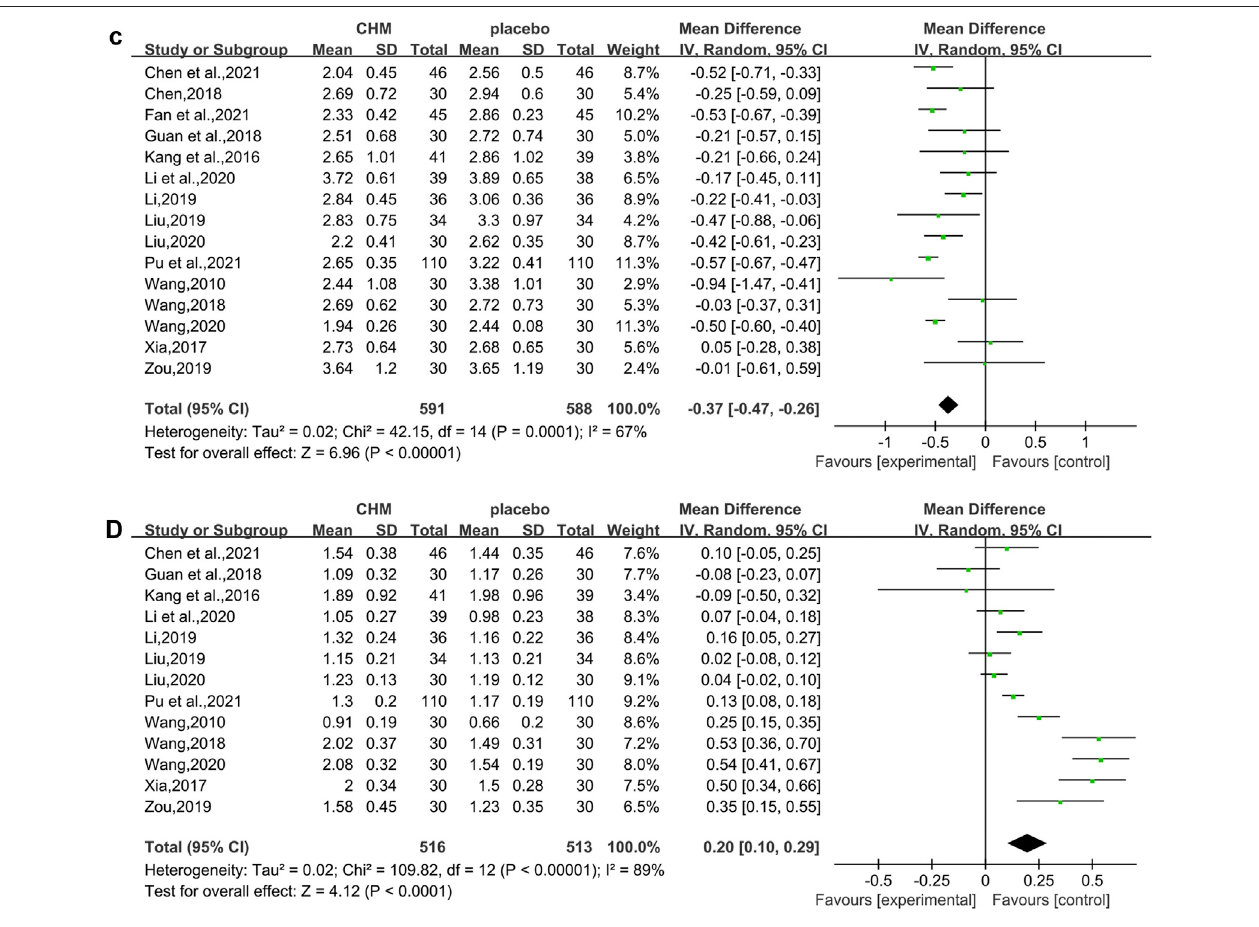
FIGURE 4 | Forest plot for lipid indices. (A) TG; (B) TC; (C) LDL-C; and (D) HDL-C.